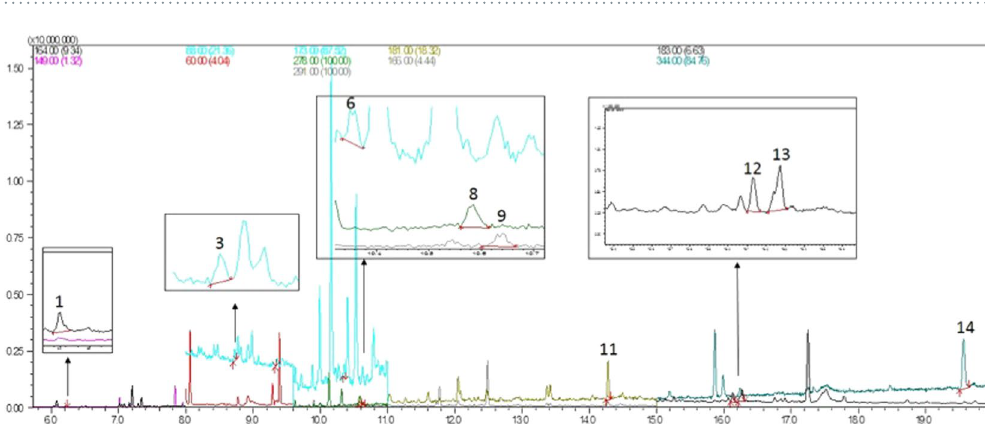
Table 3. Method validation parameters. a p-value (lack of fit test) = p value (p < 0, 05) for lack of fit test.